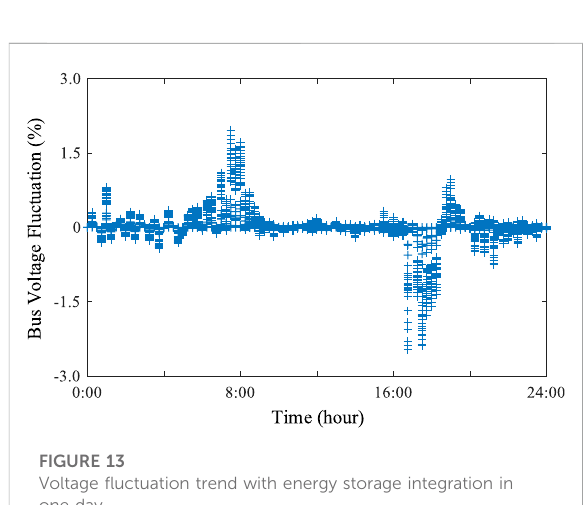
FIGURE 13 Voltage fl uctuation trend with energy storage integration in one day.